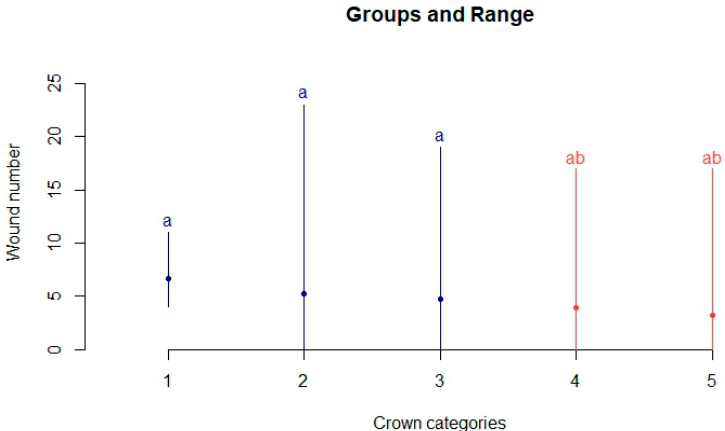
Figure 6. Height to wound distribution frequency showing that 95% of the trees had wounds located lower than 3.2 m ( p -value = 3.154 × 10 − 15 ; field measurements).